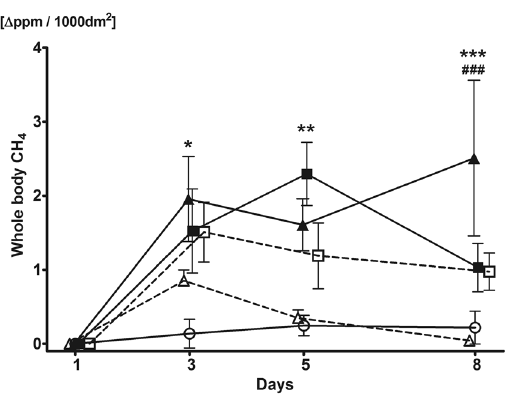
Figure 3. Whole-body CH 4 release of rats. Whole body CH 4 production was measured on days 1, 3, 5, and 8 of the investigation. Ethanol feeding induced significant CH 4 production by the 3 rd day in the 1.15 g/kg/day alcohol-treated group and by the 5 th day in the 2.7 g/kg/day alcohol-treated group, compared to control group. However, in the GPC-treated groups no increase was observed as compared to controls. Empty circles with continuous line relates to control group, black triangles with continuous line to the 1.15 g/kg/day alcohol-treated group, empty triangles with dashed line to the 1.15 g/kg/day alcohol + GPC-treated group, black squares with continuous line to 2.7 g/kg/day alcohol-treated group, and empty squares with dashed line to the 2.7 g/kg/day alcohol + GPC-treated group. During the measurement on day 1, all the rats were untreated. Mean values and standard error of mean (SEM) are given; * p < 0.05, ** p < 0.01 and *** p < 0.001 vs . Control group, ### p < 0.001 vs . corresponding GPC-treated groups. Statistics: Two-way ANOVA, Bonferroni post-hoc